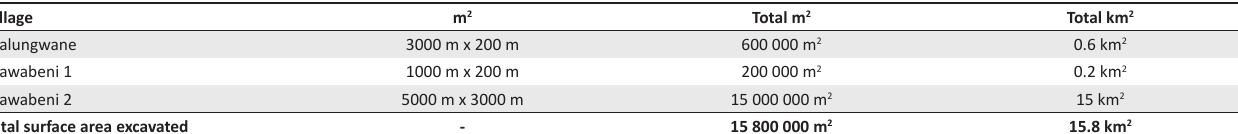
FIGURE 7: Excavations and land degradation in Mawabeni. TABLE 6: Artisanal small-scale mining areas. Village